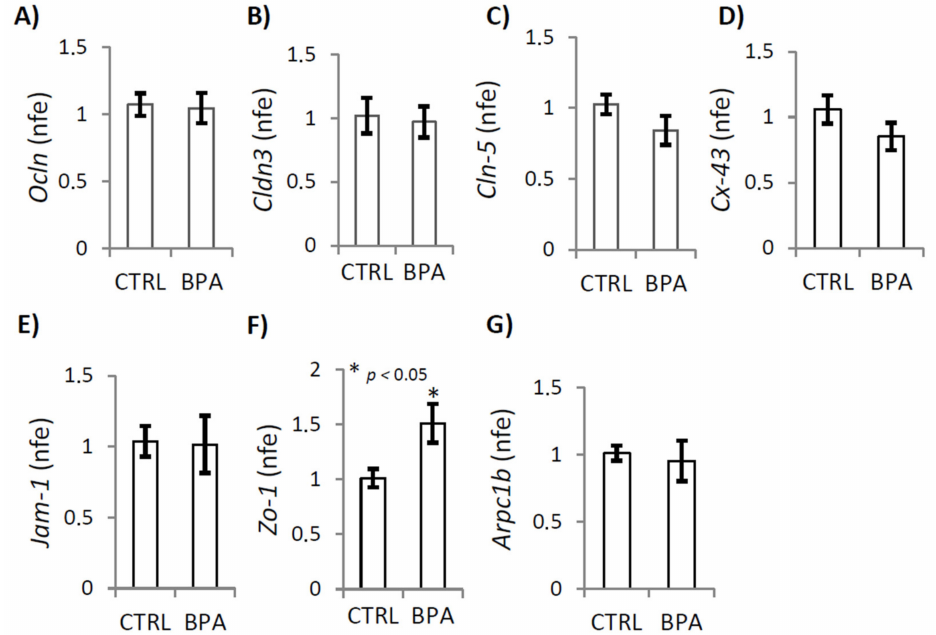
Figure 7. Gene expression analysis of some proteins organizing or modulating cell–cell junctional complexes in testis of male mice early-life exposed to vehicle (CTRL, n = 3/4) or BPA (BPA, n = 4) and sacrificed at 78 dpp . RTqPCR analysis of Ocln , Cldn-3, Cldn-5, Cx43, Jam-1, Zo-1 and Arpc1b mRNA. Transcripts amounts were reported as normalized fold expression (nfe) relatively to Rps18 gene ( A – G ). All the data were reported as mean value ± S.E.M. (*: p < 0.05).